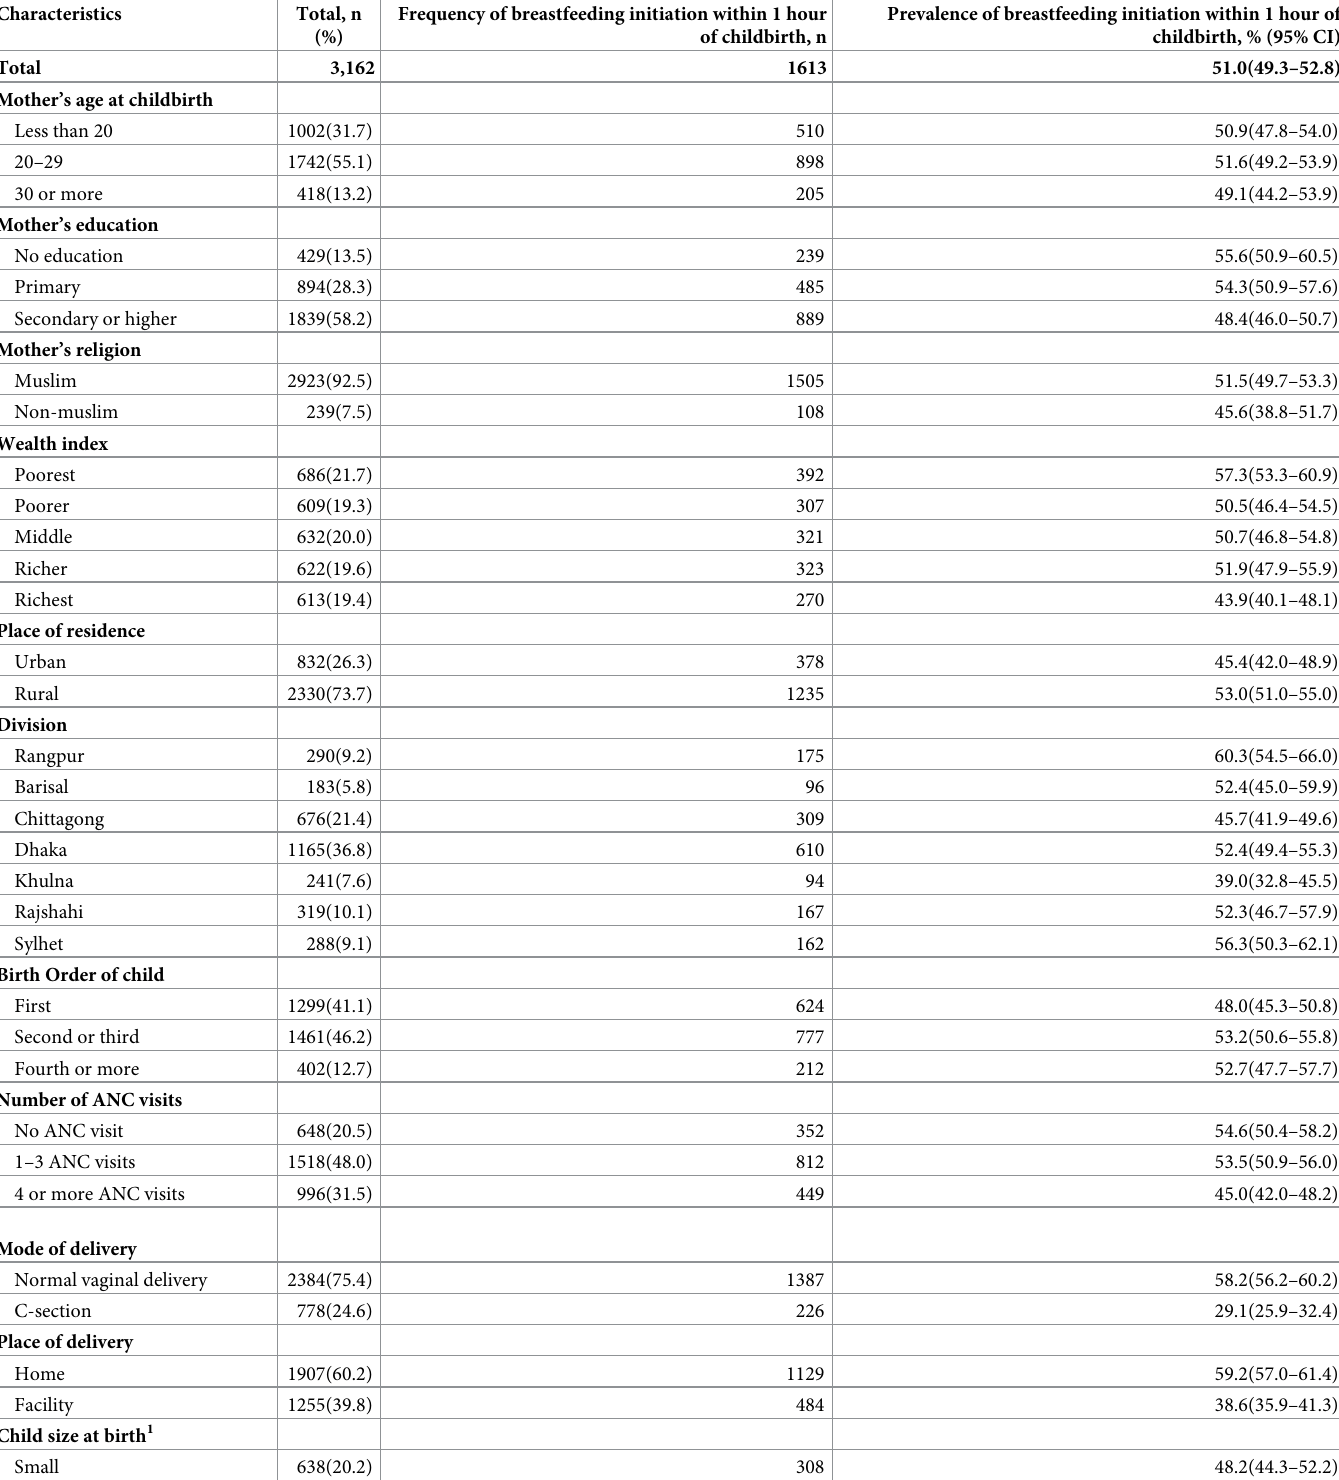
Table 1. Percentage distribution of study sample, frequency and prevalence of initiation of breastfeeding within one hour of childbirth by socio-demographic char- acteristics, and antenatal and perinatal care received by mother.